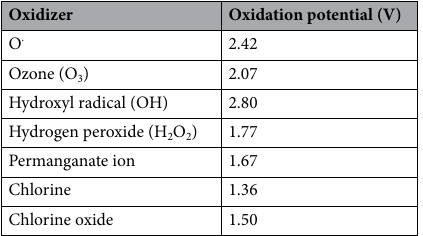
Sample labeling after plasma/catalyst